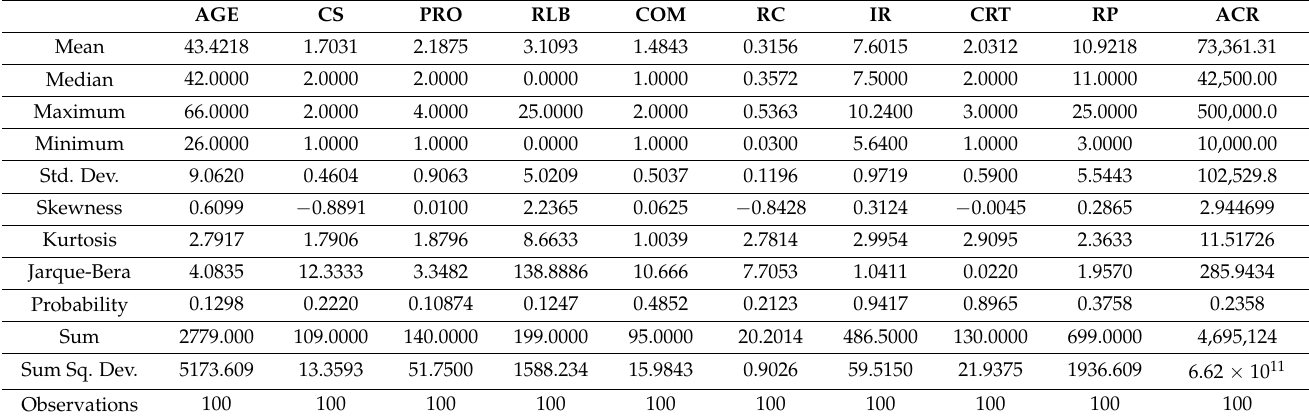
Table 1. The statistical description of the independent variable of default probability.